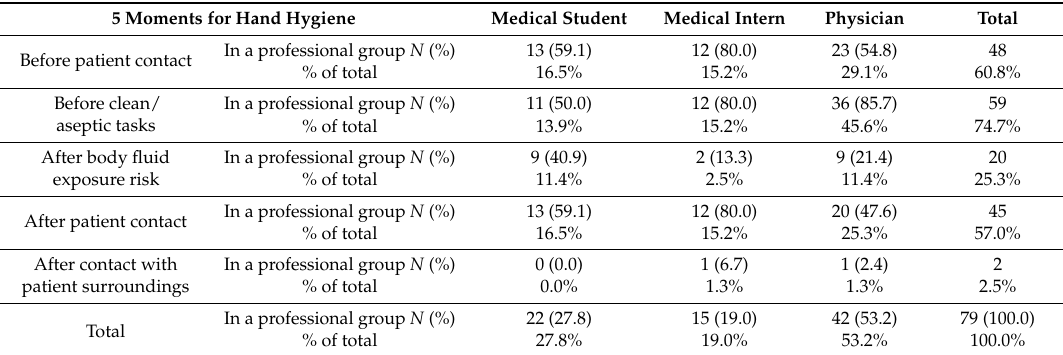
Table 3. Answers to the multiple choice question: List situations in which a healthcare worker should perform hand hygiene according to the 5 Moments for Hand Hygiene with the division into professional groups. Number of respondents: 79, no answer: